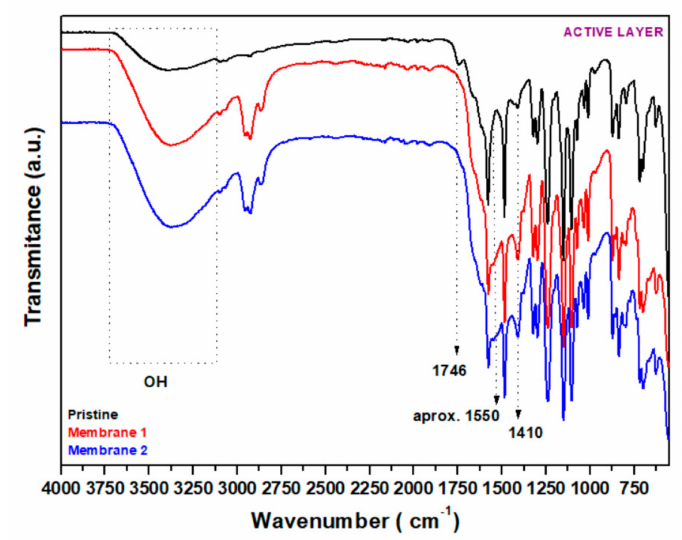
Figure 5. FT − IR spectra of the active layer of the pristine membrane and of the active layer for membranes after 12 weeks immersion in spent caustic (made in